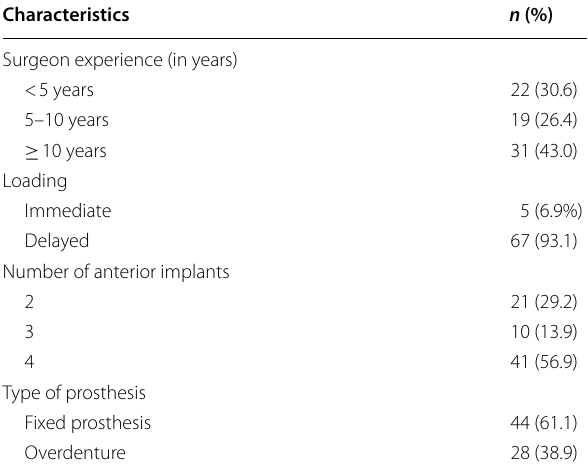
Table 4 Treatment